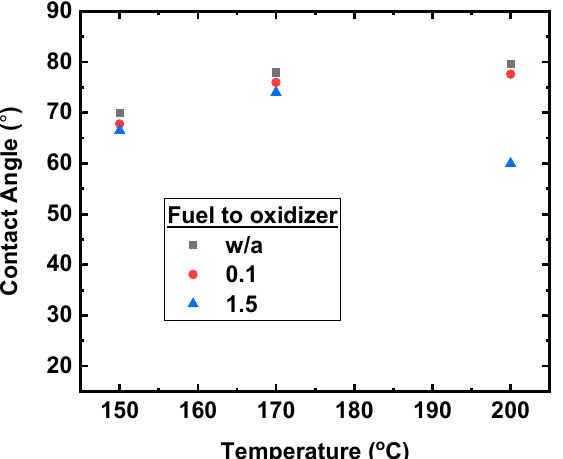
Figure 9. A graph presenting the contact angles of water on films prepared using precursor containing w/o Acac, 0.1, and 1.5 molar ratio of fuel (Acac) to oxidizer (Cu, Ni nitrates) annealed at 150, 170, and 200 °C.